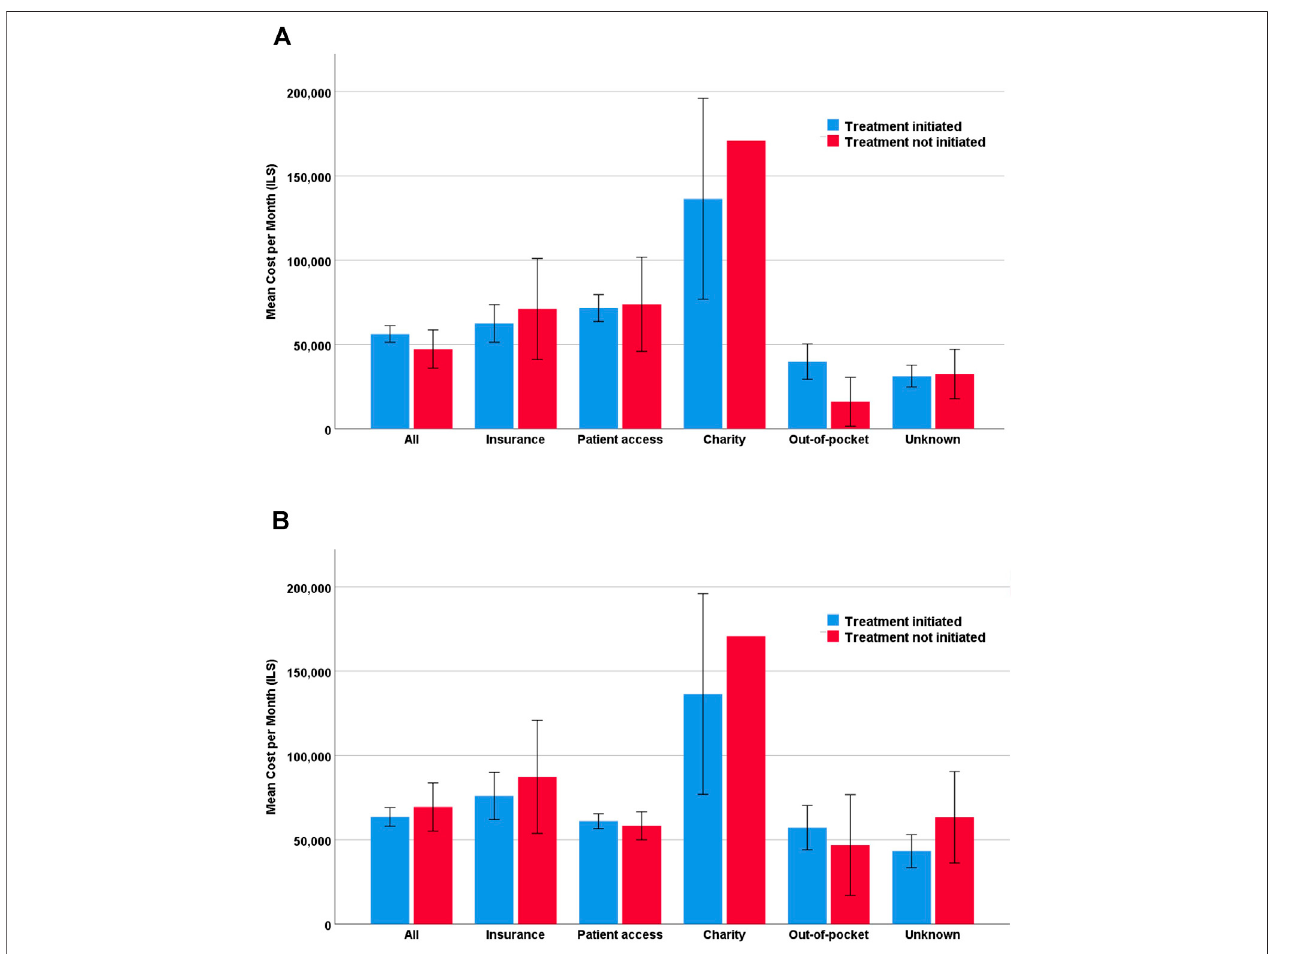
FIGURE 1 | Mean monthly cost by fi nancing source. (A) All off-label requests ( n (cid:1) 708) (B) Metastatic disease off-label requests ( n (cid:1) 491).